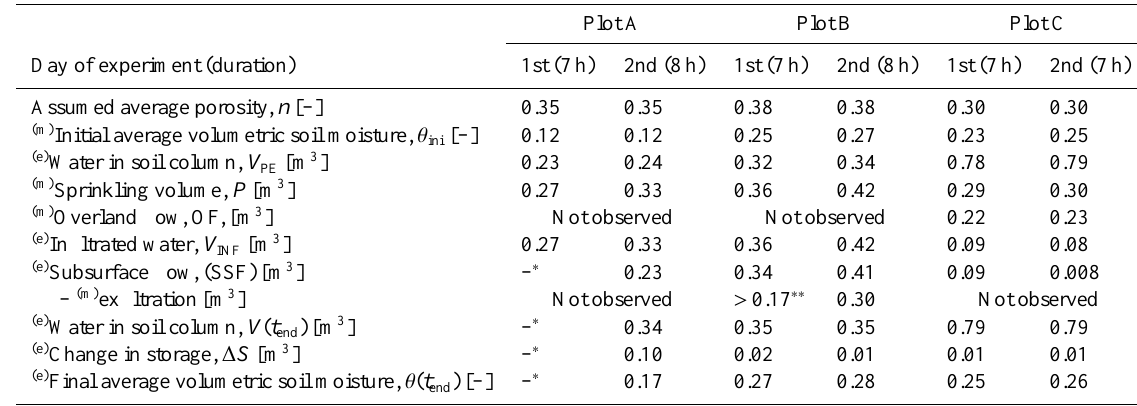
Table 1. Measured ( m ) and estimated ( e ) components of water balance for each plot, with the assumption that whole experience area is hydrologically active. Plot A Plot B Plot C Day of experiment (duration) 1st (7h) 2nd (8h) 1st (7h) 2nd (8h) 1st (7h) 2nd (7h) Assumed average porosity, n [–] 0.35 0.35 0.38 0.38 0.30 0.12